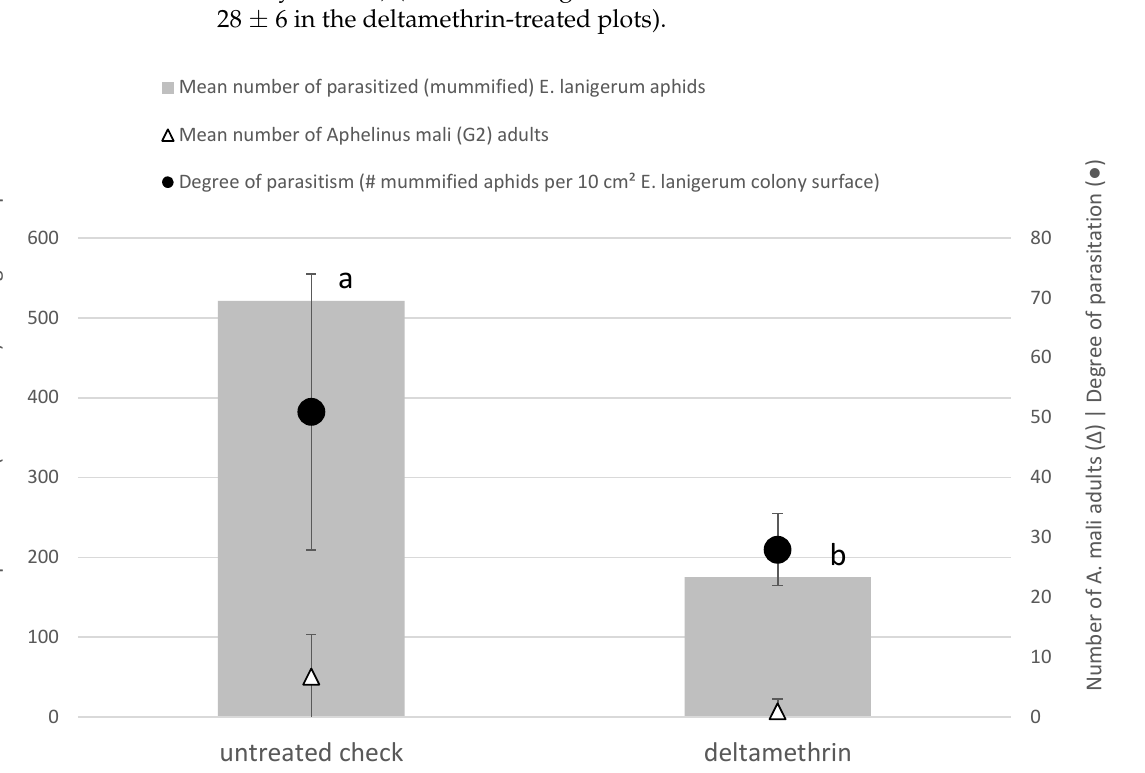
9 of 13 Figure 4. Linear regression analysis of predicted start of migration of E. lanigerum “crawlers” (= new first instar virginoparae) and observed dates of first migration activity in apple orchards monitored in this study. 3.4. Field Study on Side-Effects on A. mali and Impact on Biologicol Control of E. lanigerum In the field trial, the broad-spectrum pyrethroid insecticide Decis 15 EW was sprayed